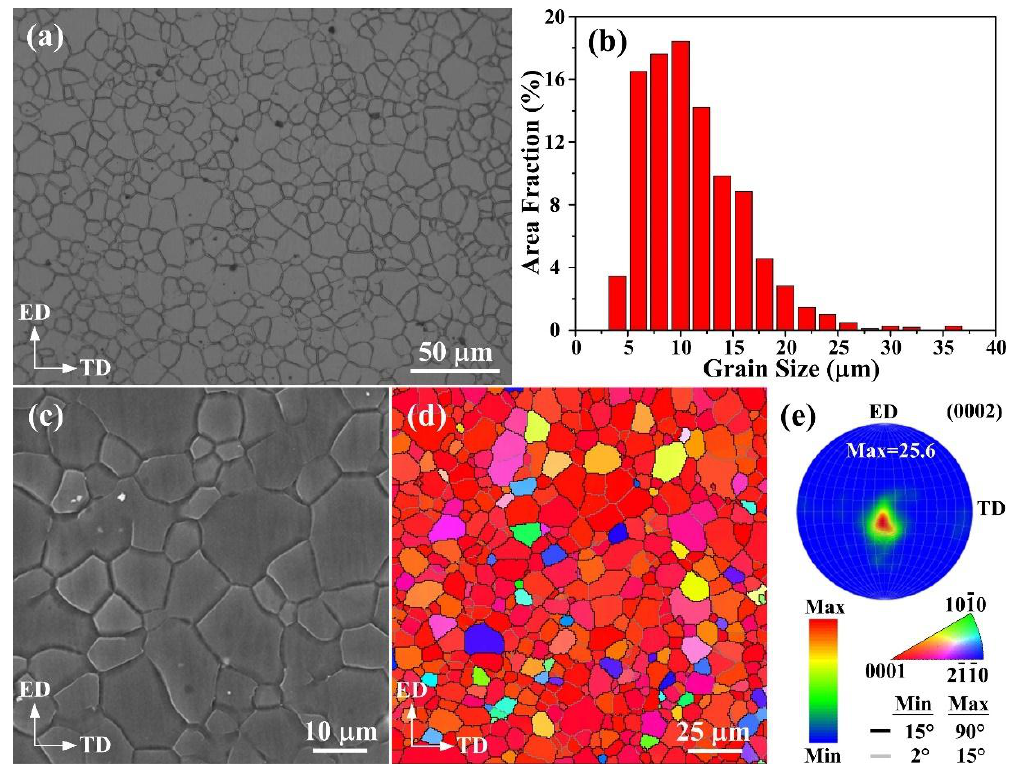
Figure 2. ( a ) Optical image, ( b ) grain size distribution, ( c ) SEM micrograph, ( d ) EBSD IPF map and ( e ) corresponding (0002) pole figure of the extruded AZ61 alloy.